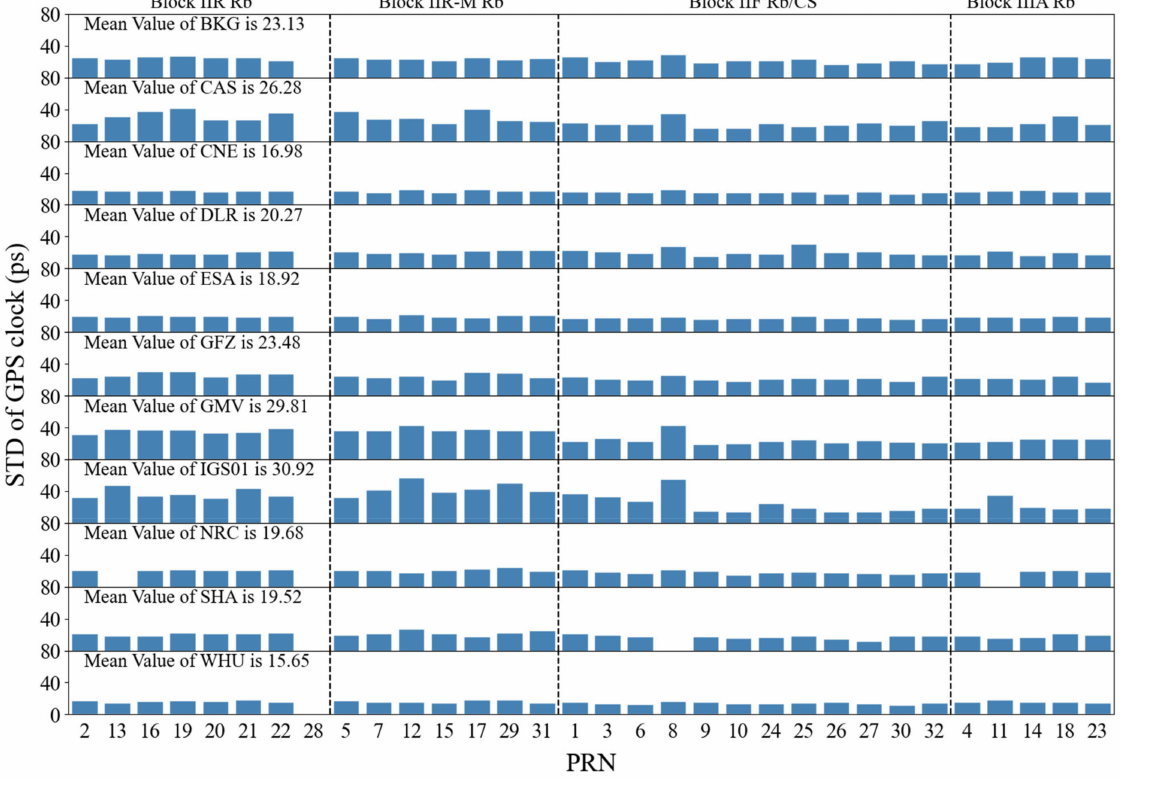
Figure 5. The standard deviations (STDs) of real-time GPS clock errors from different ACs (the mean STD of the clock errors for all GPS satellites is shown in each